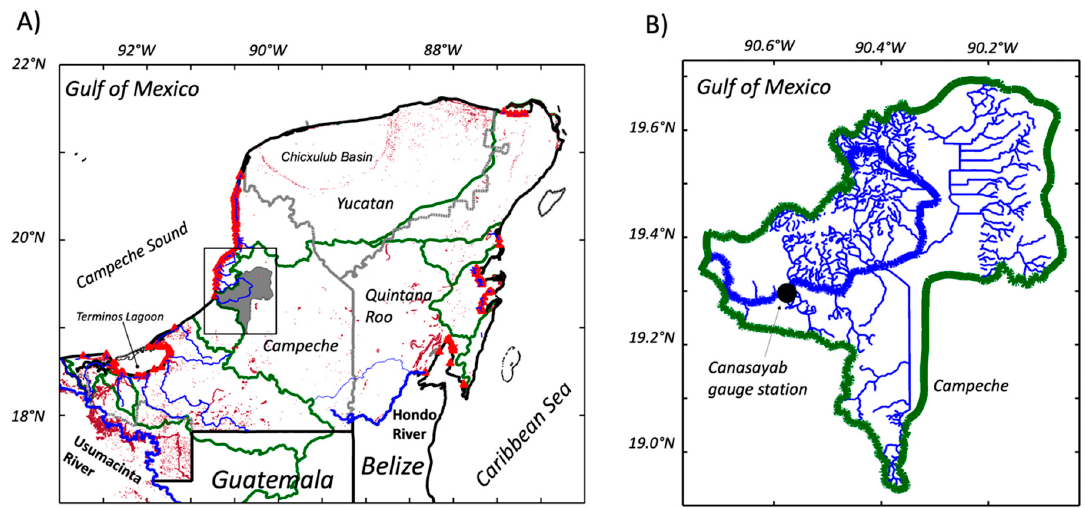
Figure 2. ( A ) Inland water bodies (purple dots) distribution in the Yucatan Peninsula. Blue lines are rivers; red triangles represent surface discharge locations along the coast; and green lines are river catchment boundaries. Mexican states and the Guatemala-Belize international boundaries are delineated by gray and dark lines, respectively; the Hondo River is part of the international boundary between Mexico and Belize. The Champoton River catchment area is shaded in gray ( A ) and enlarged in panel B .